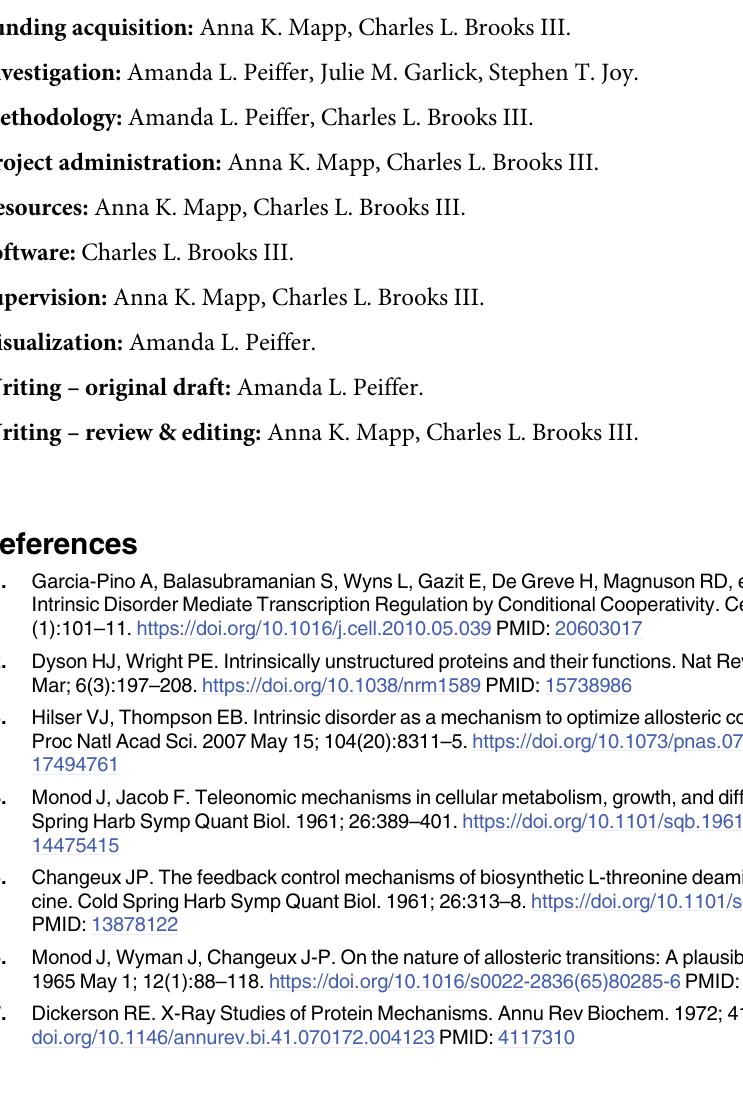
parameters in the L -G region are shown in Fig 4B. 12 2 S7 Fig. Analytical traces at 280 nm of purified peptides for A) c-Myb, B) MLL, and C) pKID. S8 Fig. DSF melt curves (left) normalized to relative fluorescence units (RFU) and the first derivative of the curves